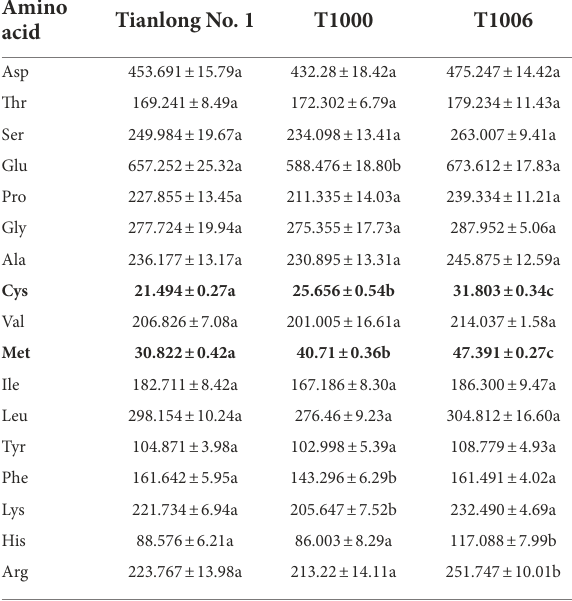
TABLE 1 The content of amino acids (nmol/mg) in dry soybean seeds from different lines. Amino Tianlong No. acid